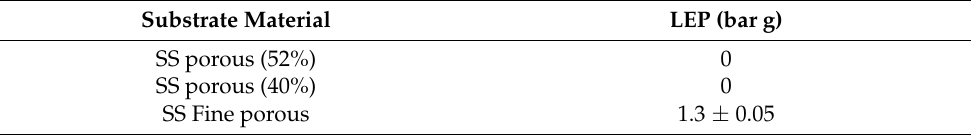
Table 2. Measured LEP value on the FAS coated SS porous